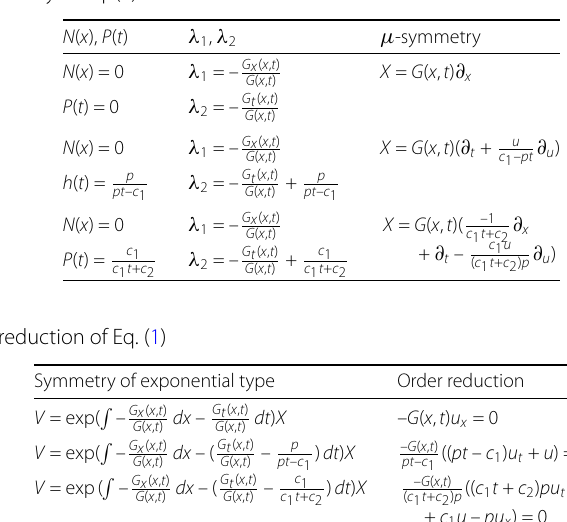
Table 6 μ -symmetry of Eq. (1)